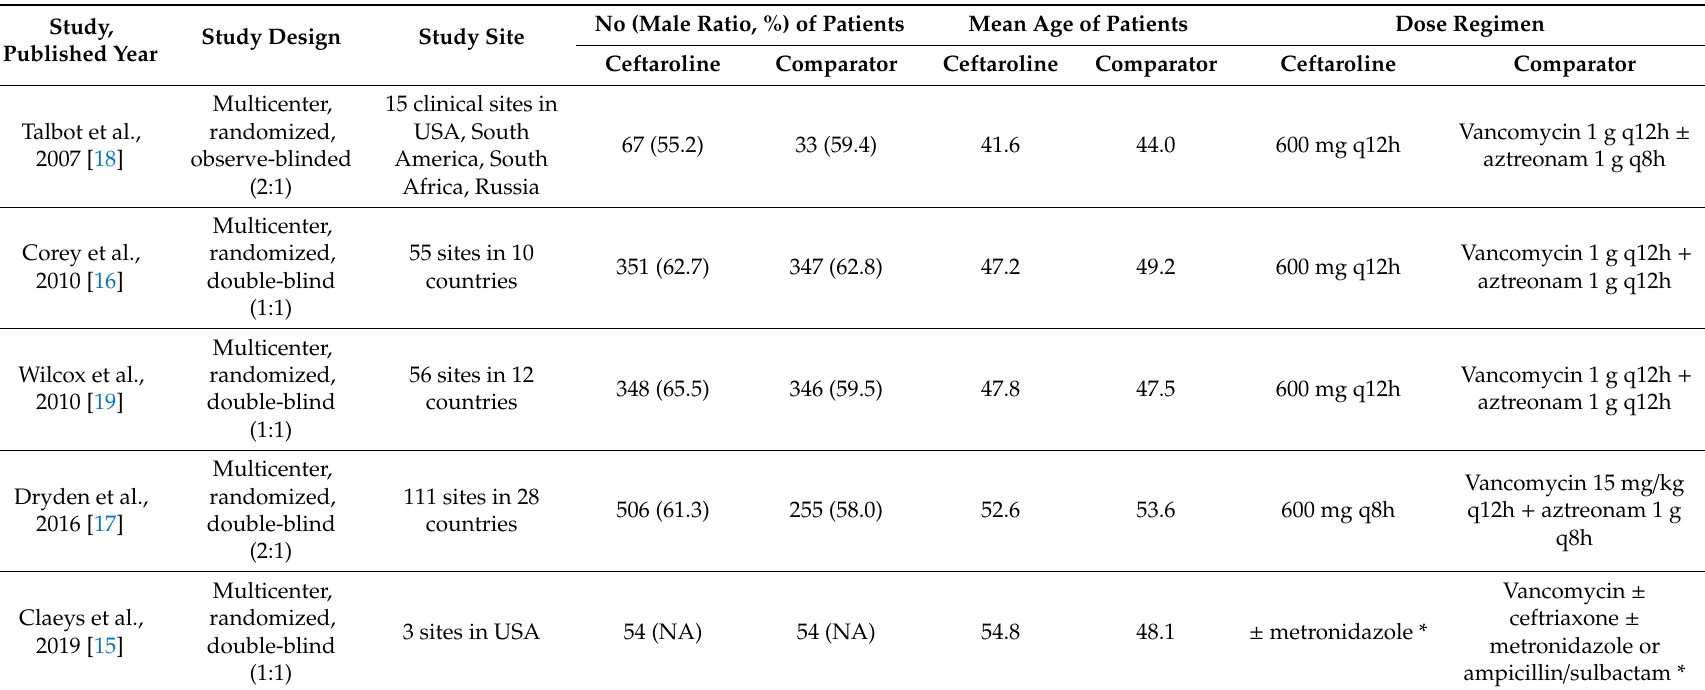
Table 1. Clinical trial